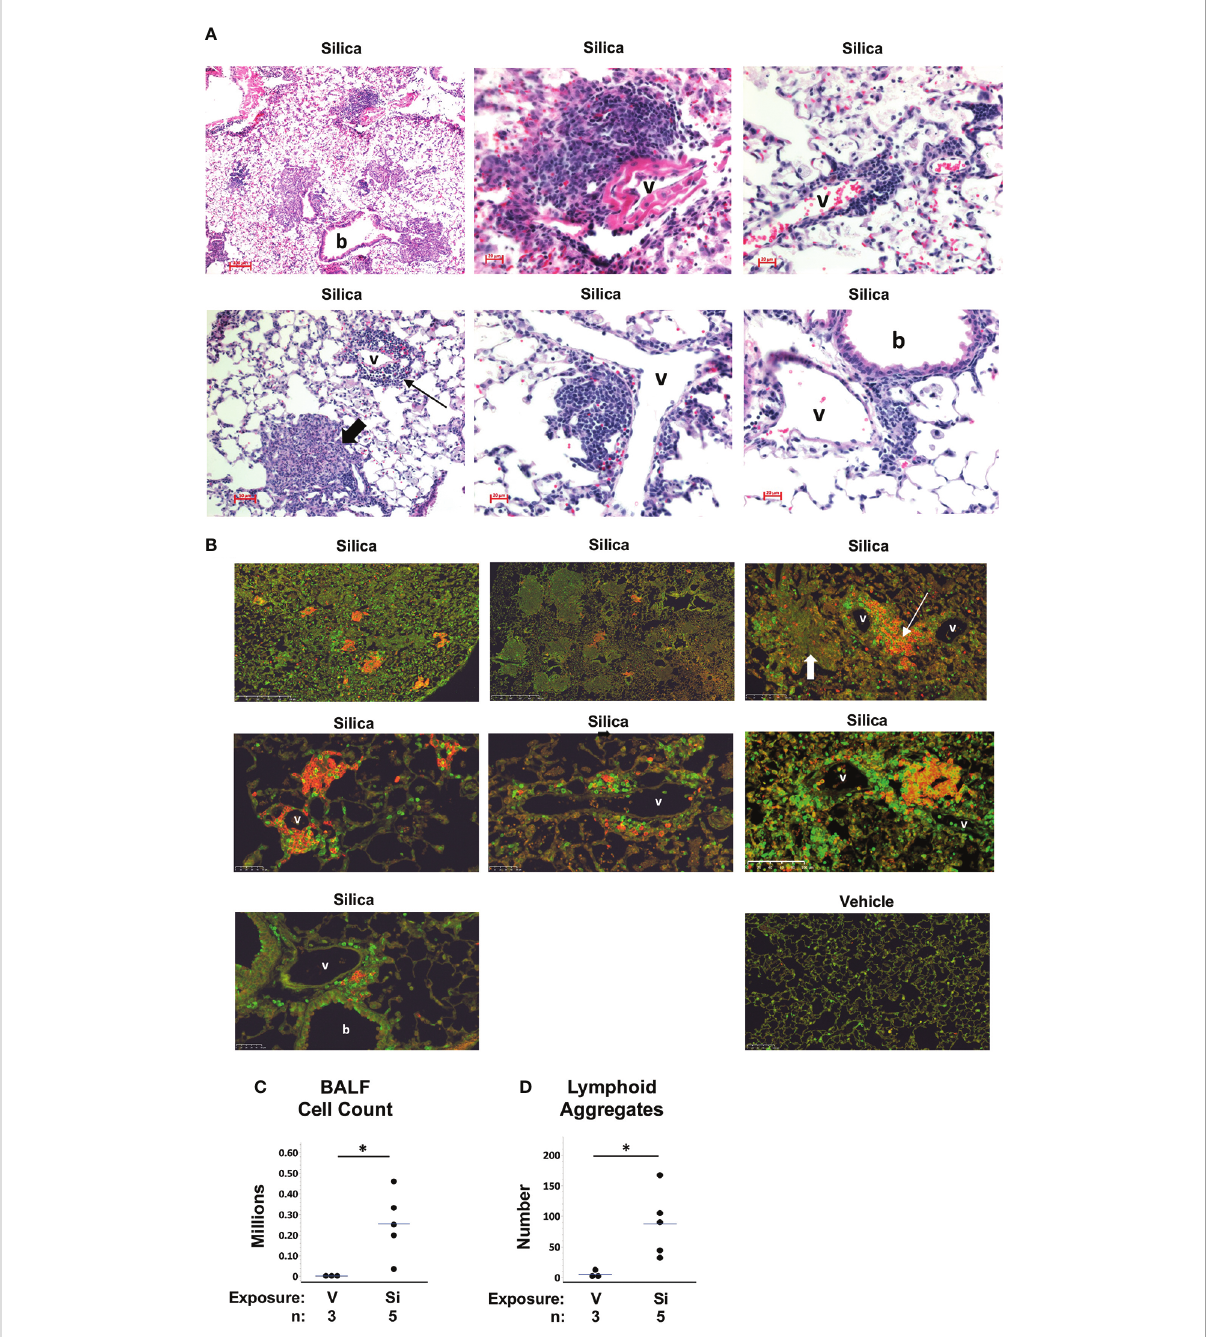
FIGURE 3 Lung in fl ammation and lymphoid aggregates in lungs of autoantibody M7 transgenic (Tg) Tg/WW mice exposed to respiratory crystalline silica or vehicle. Representative sections of lungs from M7 Tg/WW mice exposed to silica or saline (vehicle) by oropharyngeal aspiration at 5 to 6 weeks prior to organ harvest are stained with: (A) H&E; and, (B) Anti-B220 (B cells, red) and anti-CD3e (T cells, green); overlap of B and T cells yields yellow color in some sections. Magni fi cation is indicated by micron bar. Lung sections from 3 different silica-exposed Tg/WW mice are shown in (A) and from 3 different silica-exposed mice and a vehicle-exposed mouse in (B) . Example lymphoid aggregates are indicated by the thin arrows and example granulomas by the short thick arrows; b = bronchiole; v = blood vessel. In (A) the middle image in the top row shows detail within the lower power image on its left. (C) Leukocyte counts in bronchoalveolar lavage fl uid (BALF). (D) Number of lymphoid structures per whole lung section. For scatterplots each circle represents an individual mouse; the bar indicates the mean for each group. *p < 0.05; for silica- vs. vehicle-exposed mice, Wilcoxon rank sum